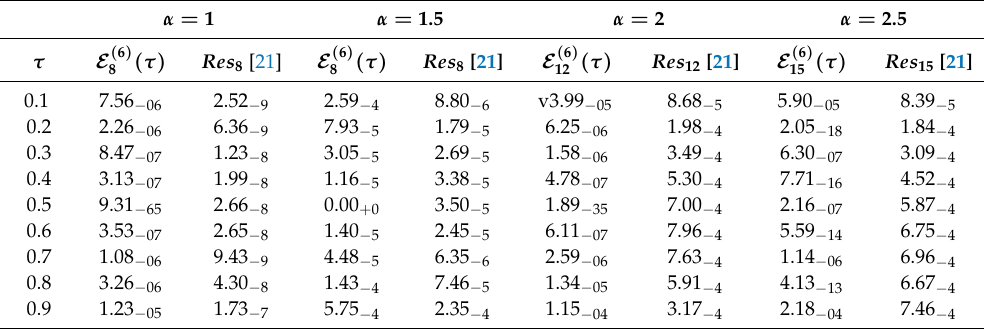
Figure 5. Numerical solutions in QLM-Bessel for M = 10, r = 5, and various α . Table 3. Comparison of numerical results in QLM-Bessel for α = 1,1.5,2,2.5, M = 8,12,15, and some [ 0,1 ] τ ∈